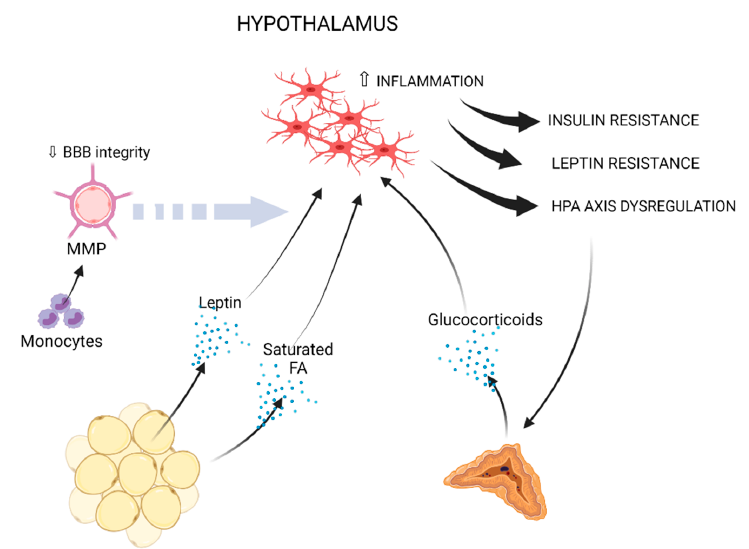
Figure 2. Obesity-induced peripheral immune, metabolic and endocrine factors, which may